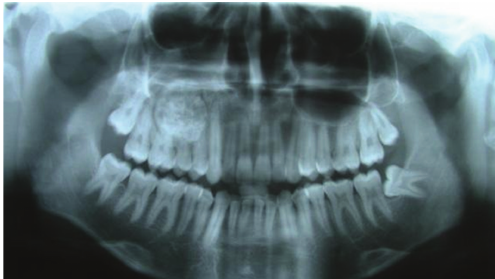
Figure 2: Orthopantomogram showing the lesion.